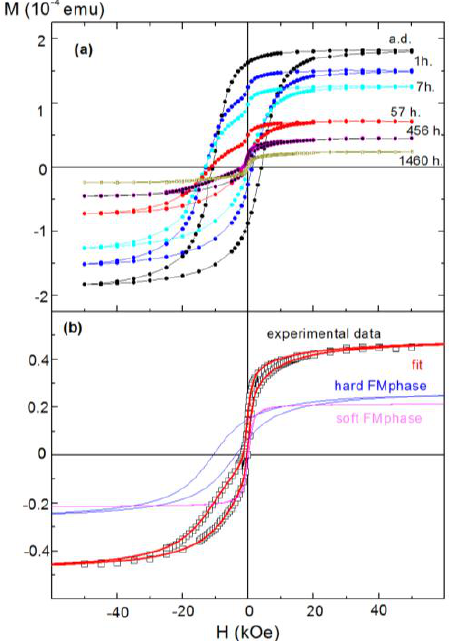
Figure 1. ( a ) Hysteresis loops, recorded at 10 K after cooling from room temperature under an applied field of 50 kOe, measured in the as-deposited sample (ad) and after air-annealing at 100 °C for different (cumulative) times; ( b ) Example of one of the fits to the hummingbird-like loops (that of the 456 h annealed sample), obtained using a combination of a hard and a soft FM phase (after correcting the data for vertical shift).